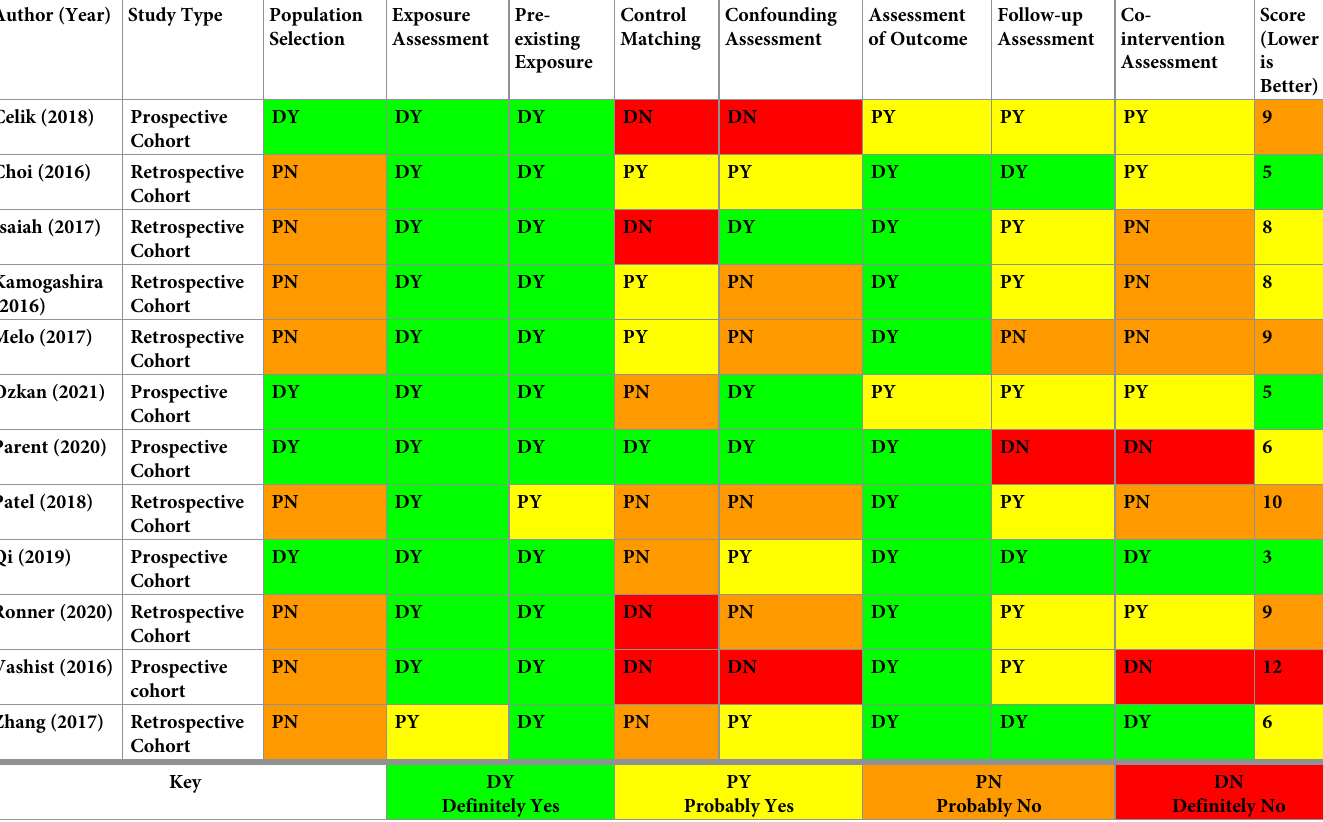
Table 3. The results of risk of bias analysis for the 12 studies examined in this review using the Cochrane cohort study risk of bias